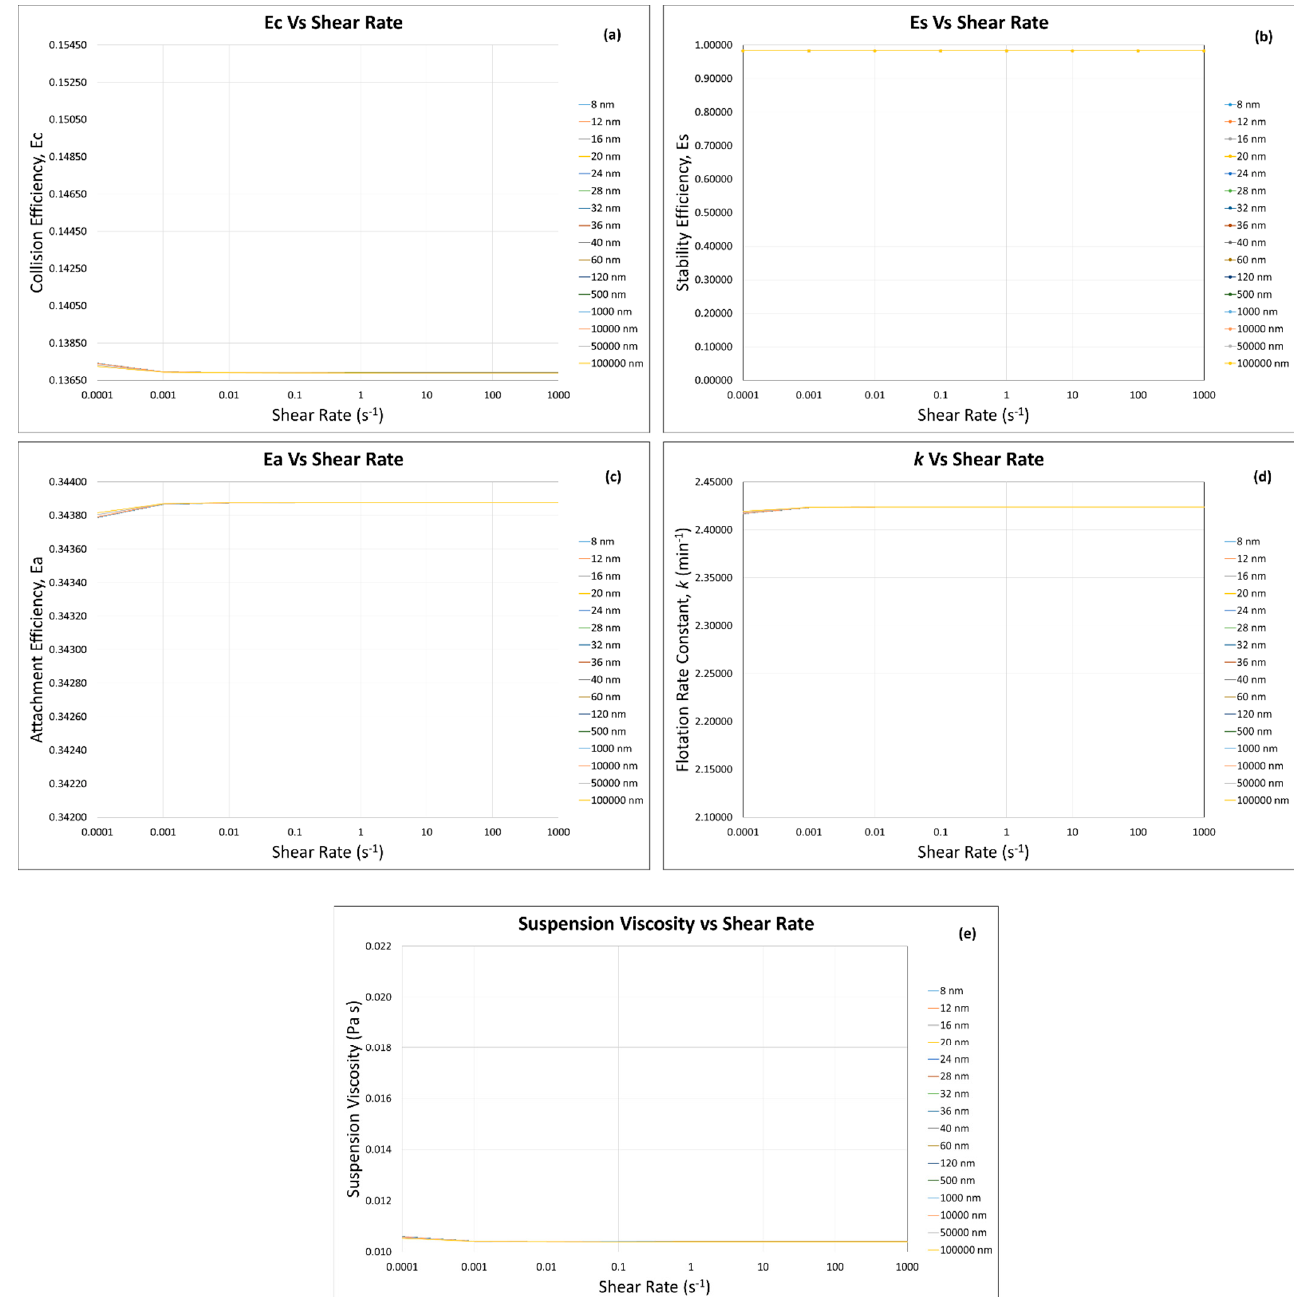
Figure 14. Flotation efficiencies: ( a ) collision, ( b ) stability, ( c ) attachment, and ( d ) rate constant by using ( e ) the suspension viscosity calculated by the predictive model (same particles with different sizes ( 𝑎 (cid:2869) : 𝑎 (cid:2870) = 9: 1 ), at 𝜙 = 0.5 ).